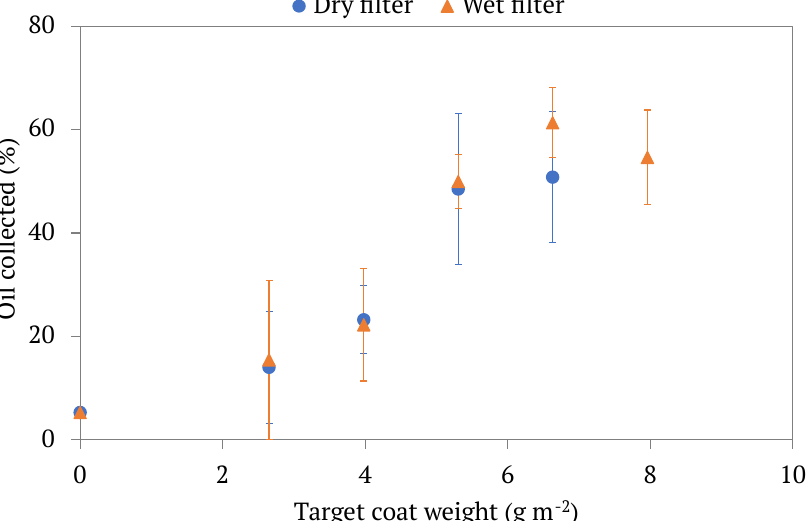
Figure 3. The oil separation efficiencies, calculated by Equation (2), of different LCNF-modified filters by coat weight. Both dry and wet filters are displayed. Each point represents the average oil separation efficiency of multiple trials of modified filters with the same target coat weight, with the standard deviations of said values being displayed in the error bars.